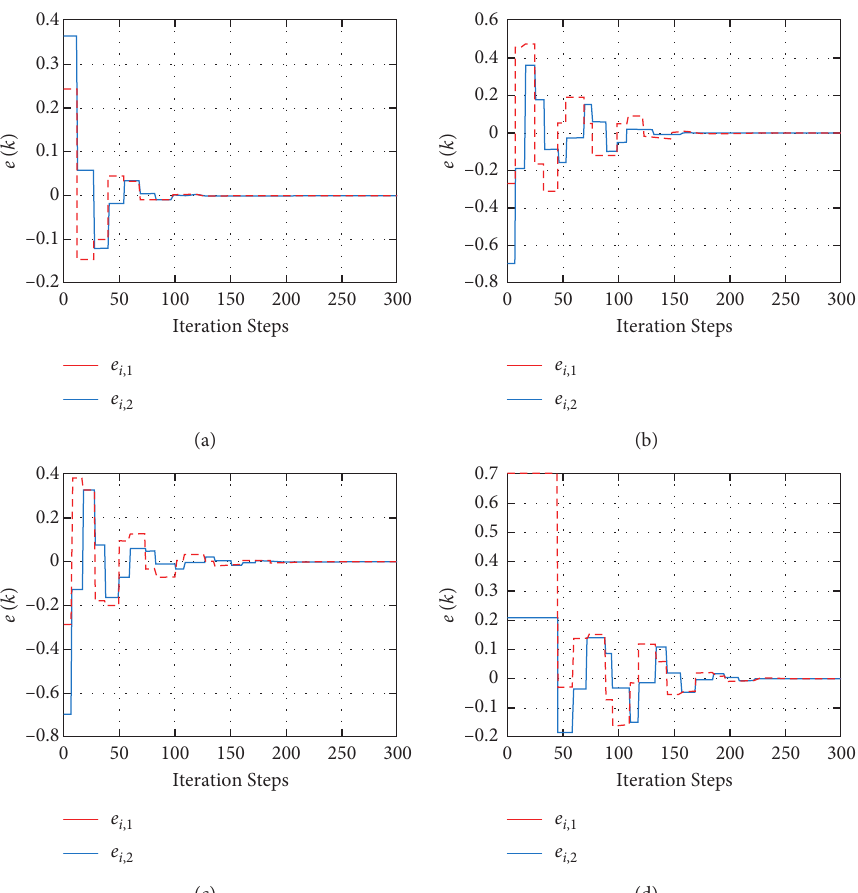
Figure 4: The driving error for every agent in the system under the ETcondition. (a) Driving error for agent1. (b) Driving error for agent2. (c) Driving error for agent3. (d) Driving error for